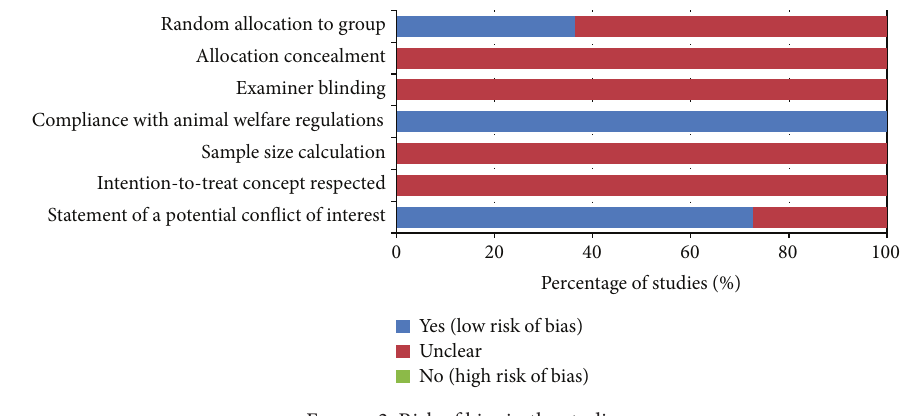
Figure 2: Risk of bias in the studies. Table 3: Basic characteristics of the animal models used in the included